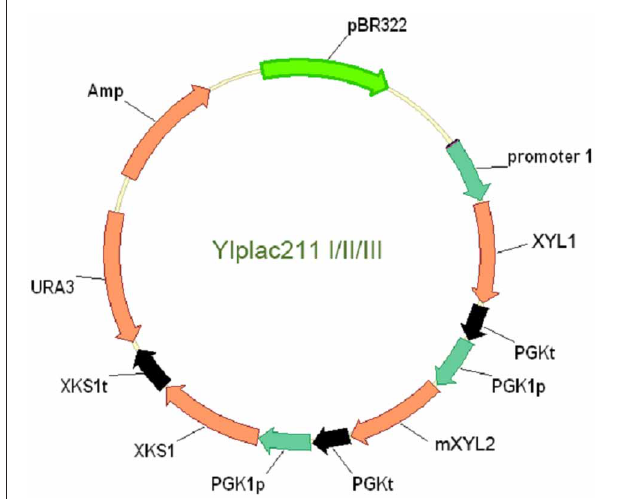
FIGURE 1 | The physical map of the plasmids YIplac211-I, II, and III for co-expression of XYL1 , mXYL2 and XKS1 in yeast W303a and L2612. Promoter 1 represents tADH1 , ADH1 , and PGK1 promoters in YIplac211-I, II and III. The transcription orientations of the three genes were the same in the plasmids.